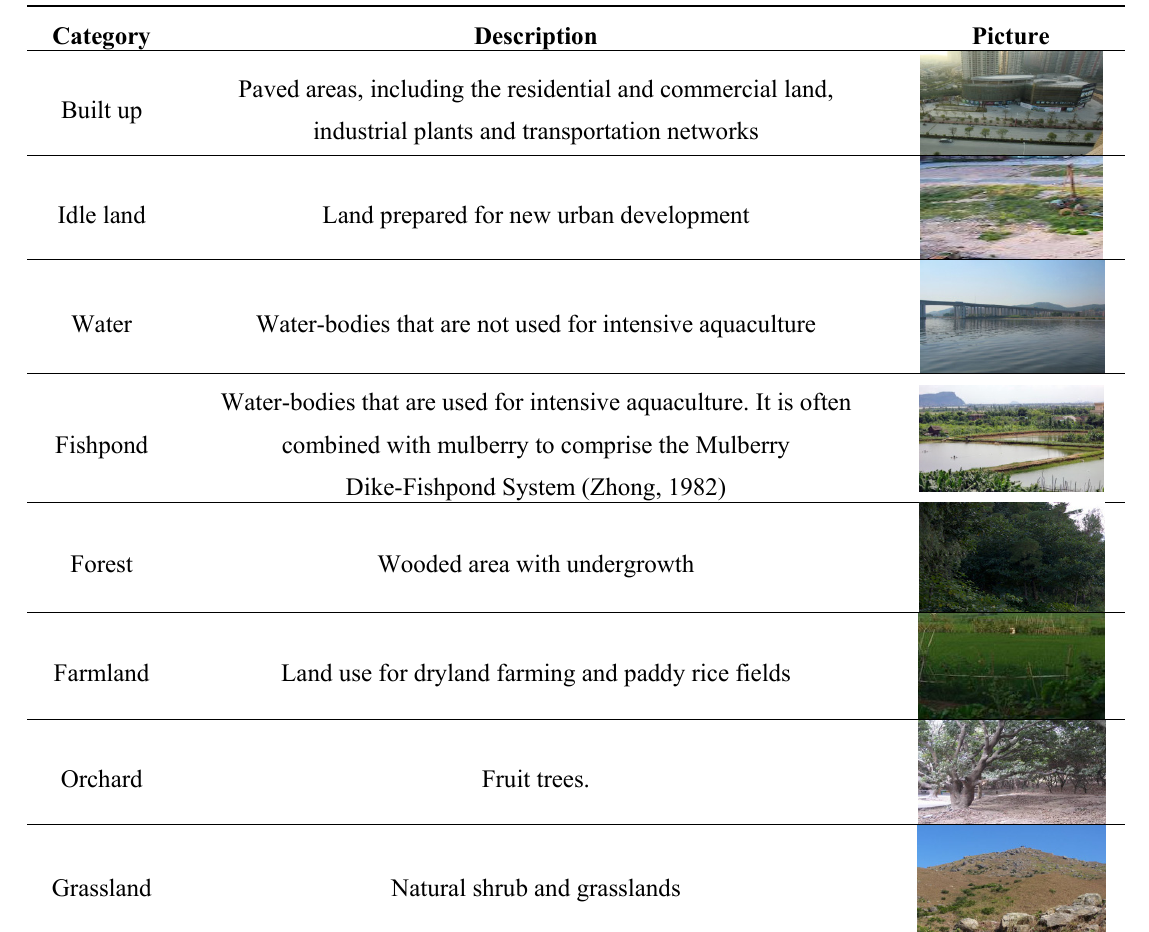
Table 2. Land use categories and its